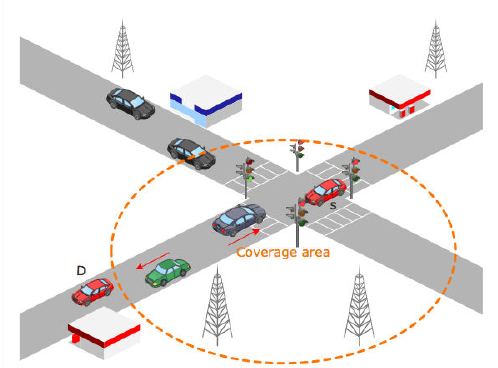
Figure 6. Node s should select the green vehicle that is moving toward destination D , thus being the node with the correct movement direction in this